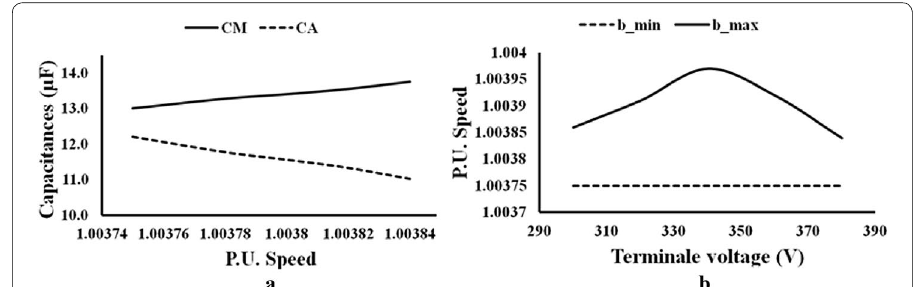
Fig. 6 a Main and auxiliary capacitance versus P.U. speed with constant terminal voltage and rated frequency at no-load conditions, b P.U. speed limits versus no-load terminal voltage at rated frequency